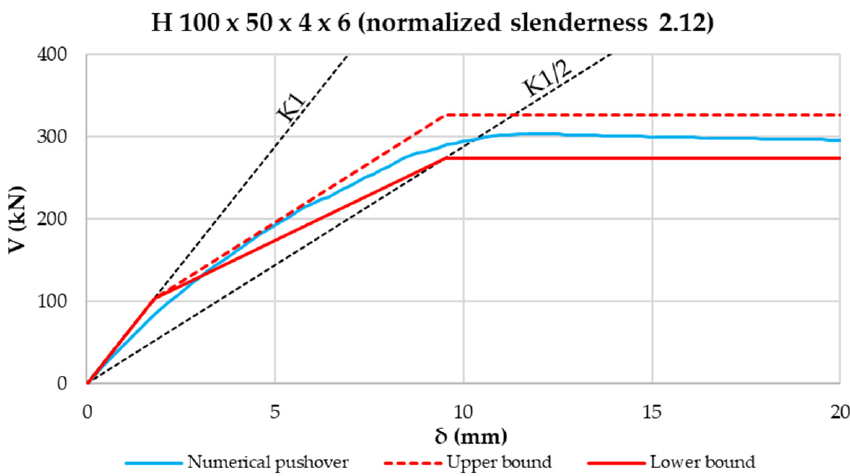
Figure 14. Comparison between analytical pushover curves and numerical one for the profile H 100 × 50 × 4 × 6. Some like “x” means “×”.